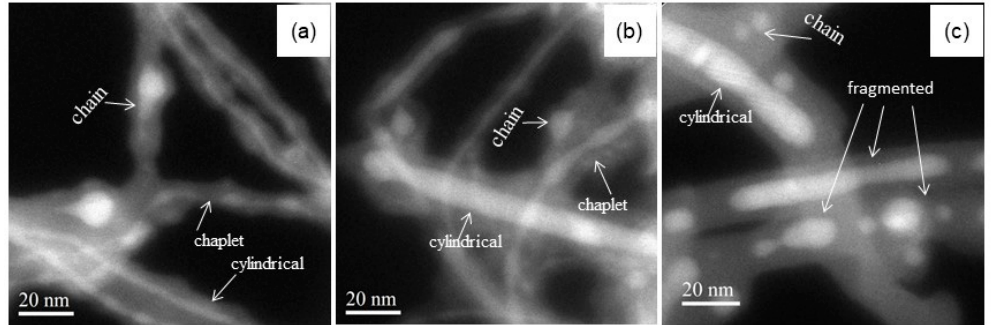
Figure 1. Typical EFTEM images recorded at the plasmon energy loss peak for Si of the as-grown ( a ), centrifuged ( b ) and 800 °C annealed ( c ) Si nanopowders. These EFTEM images reveal the Si core (whitest structures) wrapped in a silicon oxide shell (whitish casing).